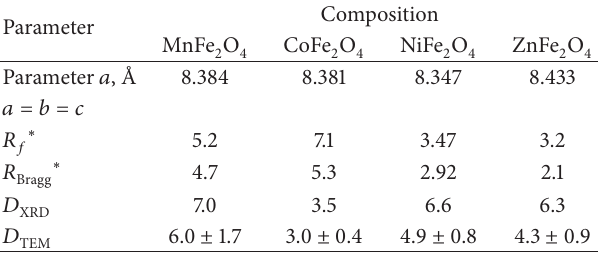
Table 1: Crystallographic parameters of the AFe Ni, Zn)